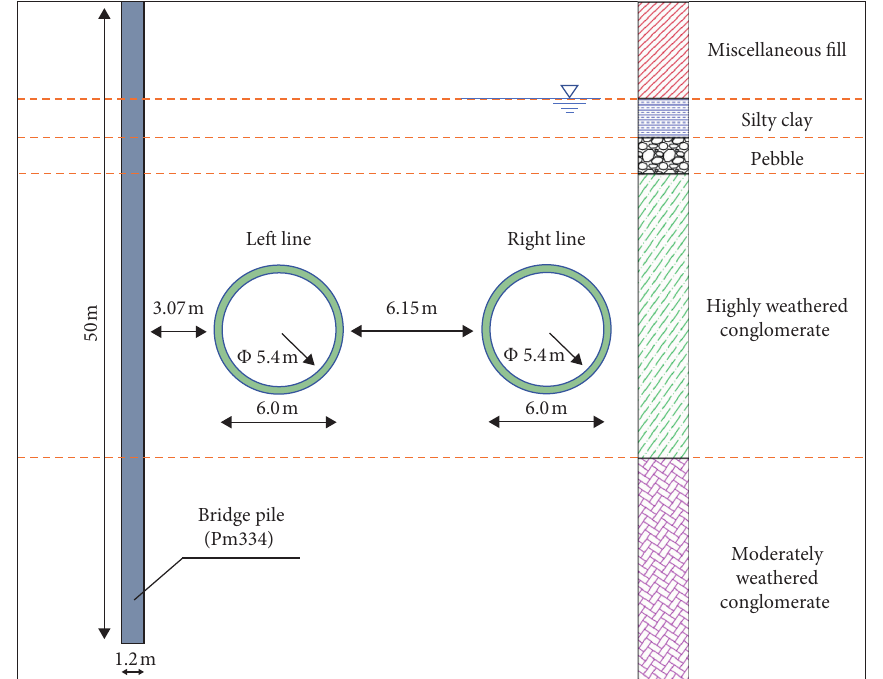
Figure 5: Engineering geology